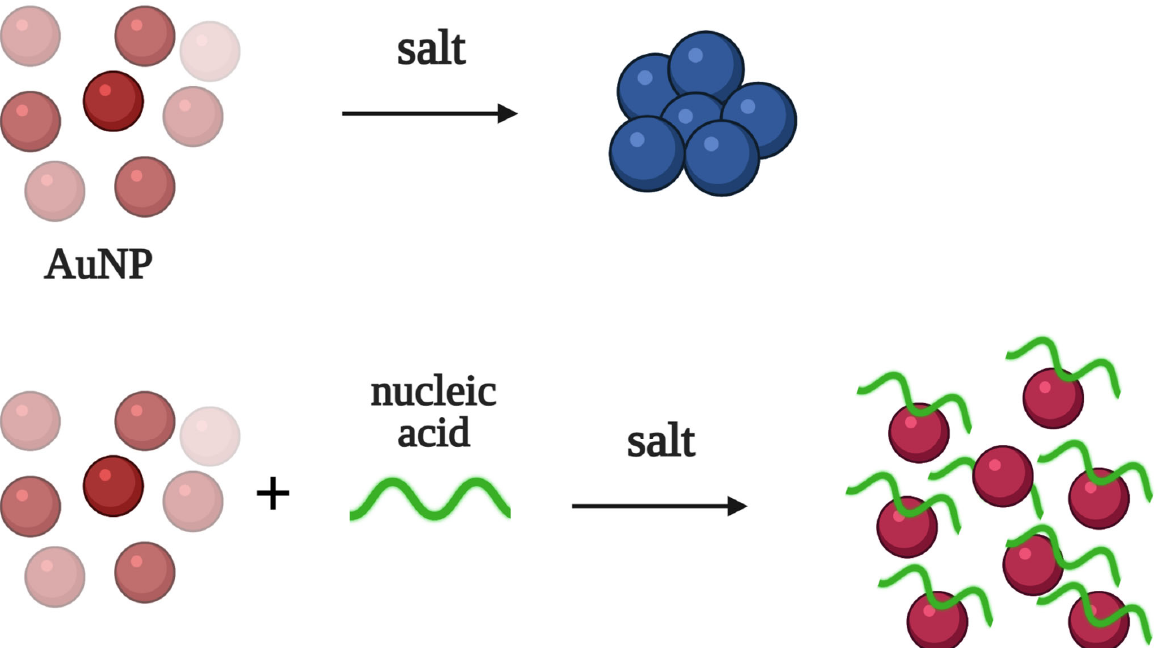
Figure 1. Colorimetric detection using the dispersion/aggregation of gold nanoparticles (AuNPs) in salted solution. Unmodified AuNPs aggregate in the salt-containing solution, turning a red colored solution into a blue solution. The non-specific absorption of nucleic acids prevents the aggregation of AuNPs, and the solution remains red.